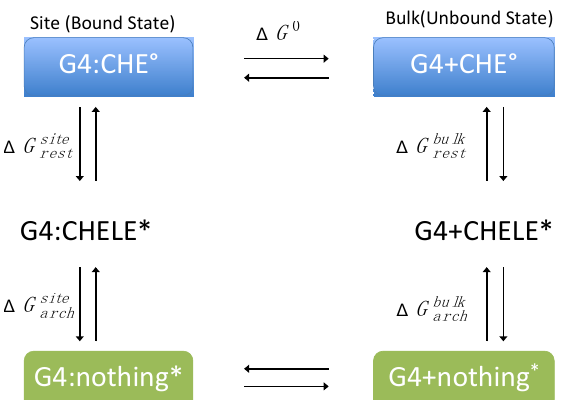
Figure 2. Thermodynamic cycle used for the calculation of the binding free energy ( ∆ G 0 ) between CHE and the G-quadruplex (G4). The symbol * stands for a restrained state in the phase space.